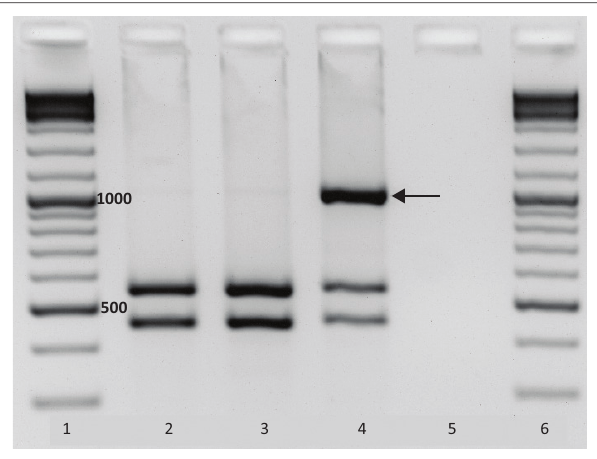
FIGURE 3: Kpn1 restriction fraction length polymorphism for c.481C>T wildtype and heterozygous variant, Western Cape, South Africa, 2013–2016. Agarose gel electrophoresis of NAT2 PCR products digested with Kpn1 restriction enzyme. The c.481C>T variant destroys a Kpn1 recognition site. Lanes 1 and 6: DNA ladder (Thermo Scientific GeneRuler DNA Ladder Mix) with relevant corresponding bp sizes indicated. Lane 2: Patient sample (no c.481C>T variation). Lane 3: Normal control (no c.481C>T variation). Lane 4: Heterozygous control (c.481C>T variation on one allele). Lane 5: Blank. The arrow demonstrates the uncut allele (1003 bp) containing the c.481C>T single nucleotide variant. The two bands (553 base pairs and 450 base pairs) below this band demonstrate the normal (and therefore cut) allele. The restriction site on the normal allele is recognised and therefore cut into smaller fragments, while the affected allele is not digested, lending itself to excision for single allele sequencing.